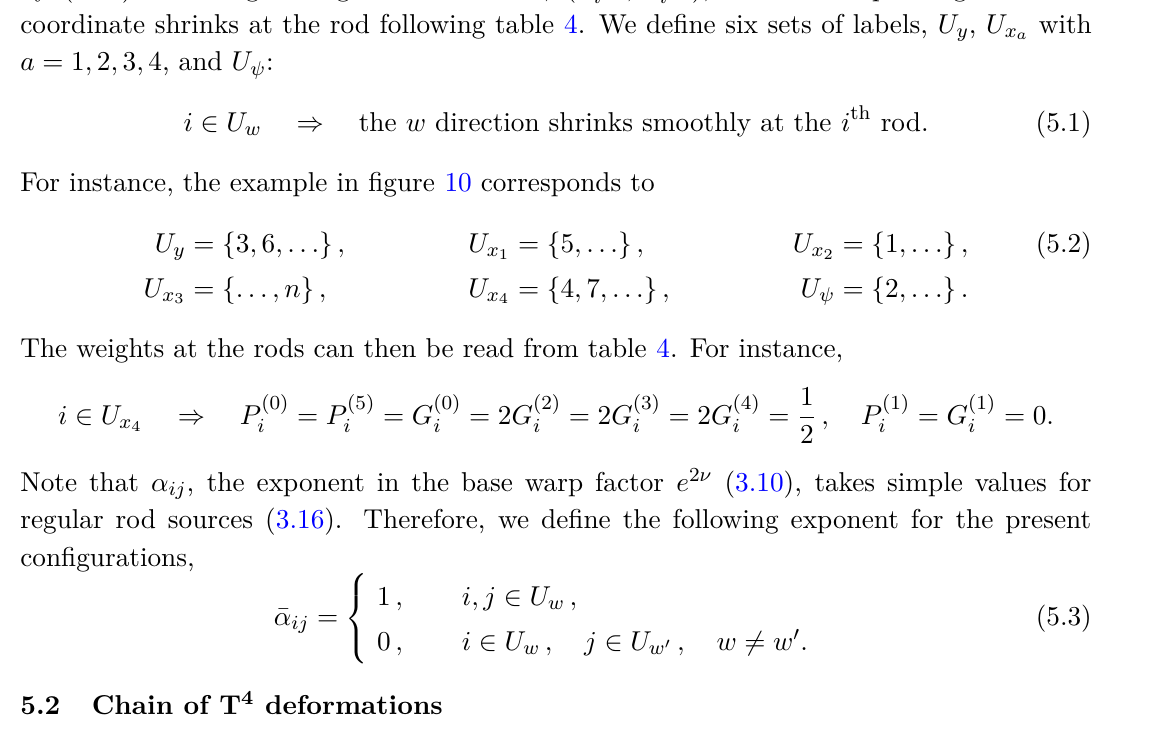
The expressions of the type IIB fields from the linear branch of solutions are given by